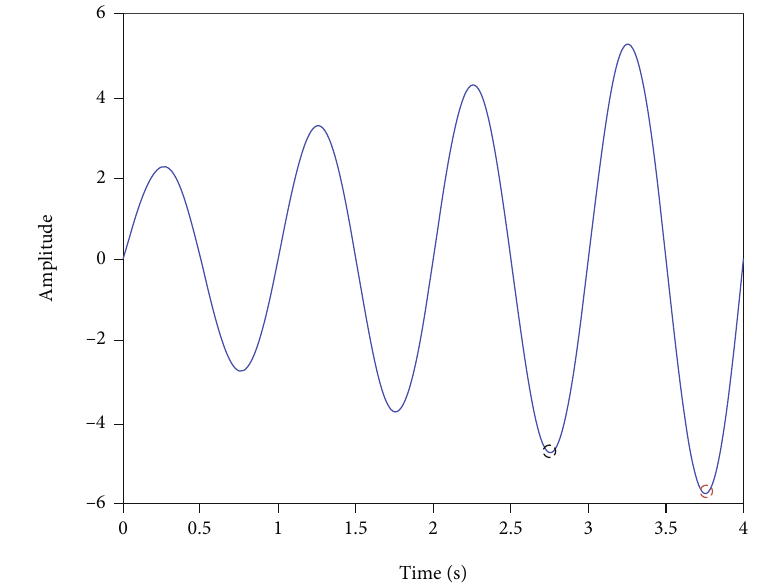
Figure 4: Example function curve.